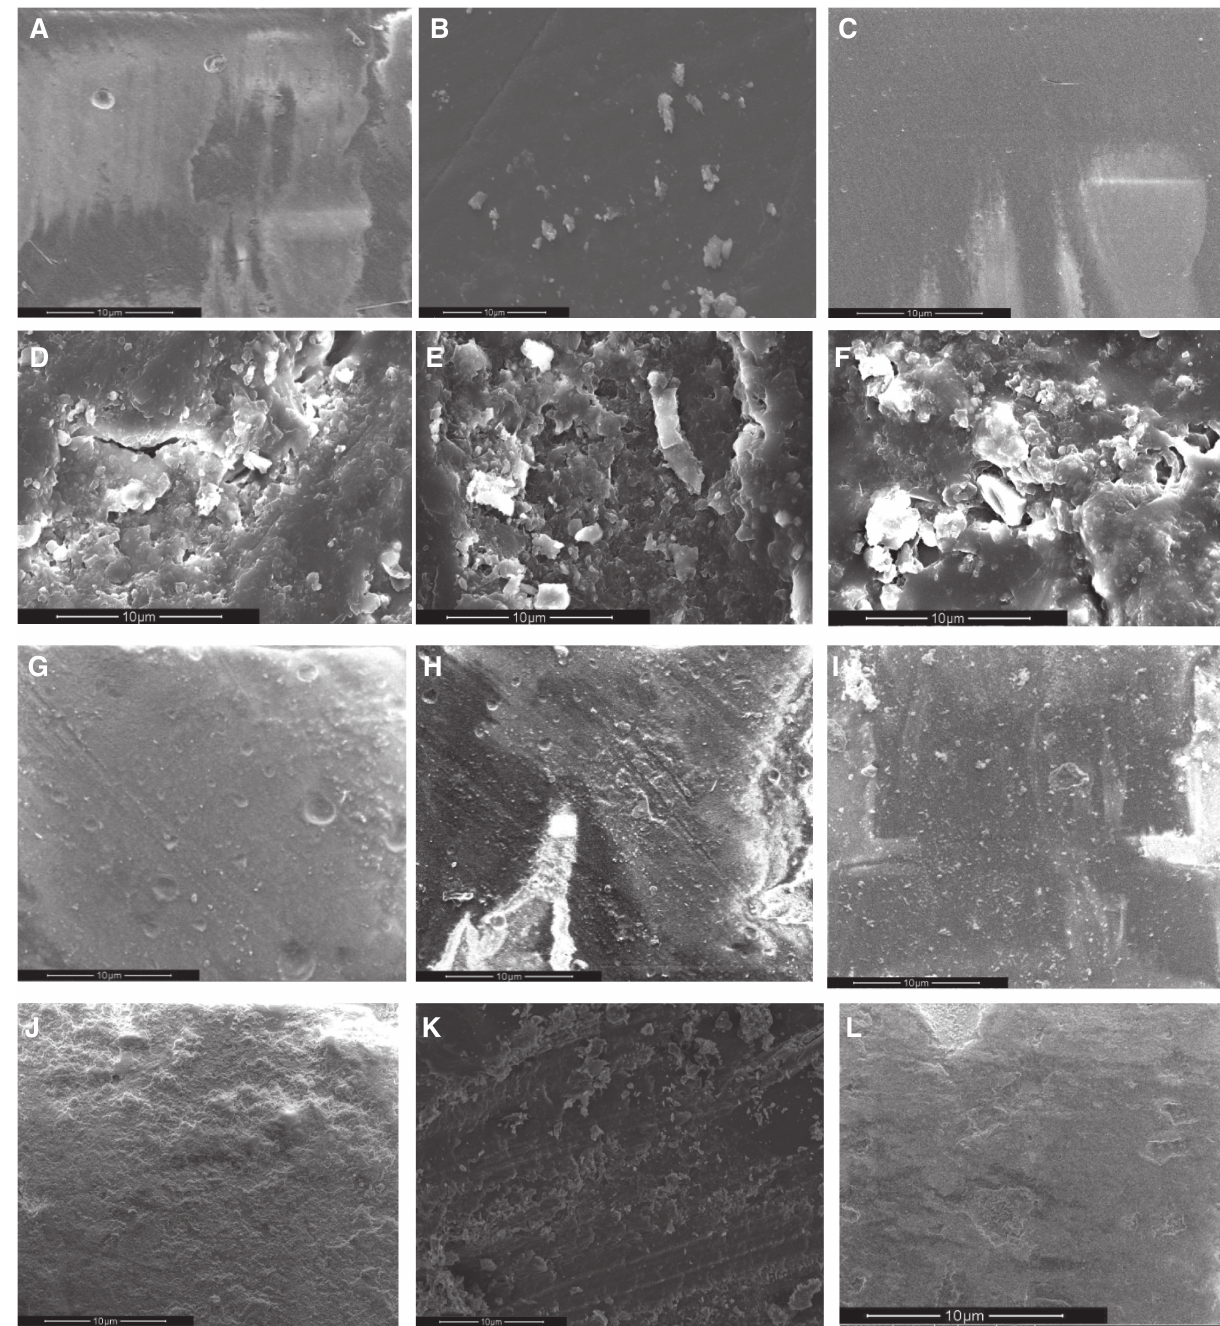
Figure 10: SEM images of cured VEOCN samples containing MMA, styrene, ME and MG as reactive monomers, respectively. Exposed to 1 m HCl: (A) MMA, (D) styrene, (G) ME and (J) MG; Exposed to 1 m NaOH: (B) MMA, (E) styrene, (H) ME and (K) MG; Exposed to 1 m NaCl: (C) MMA, (F) styrene, (I) ME and (L)